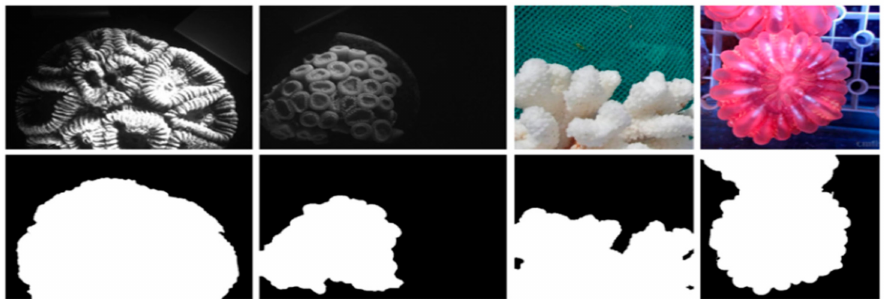
Figure A9. Examples of manual annotation of spectral and RGB images.